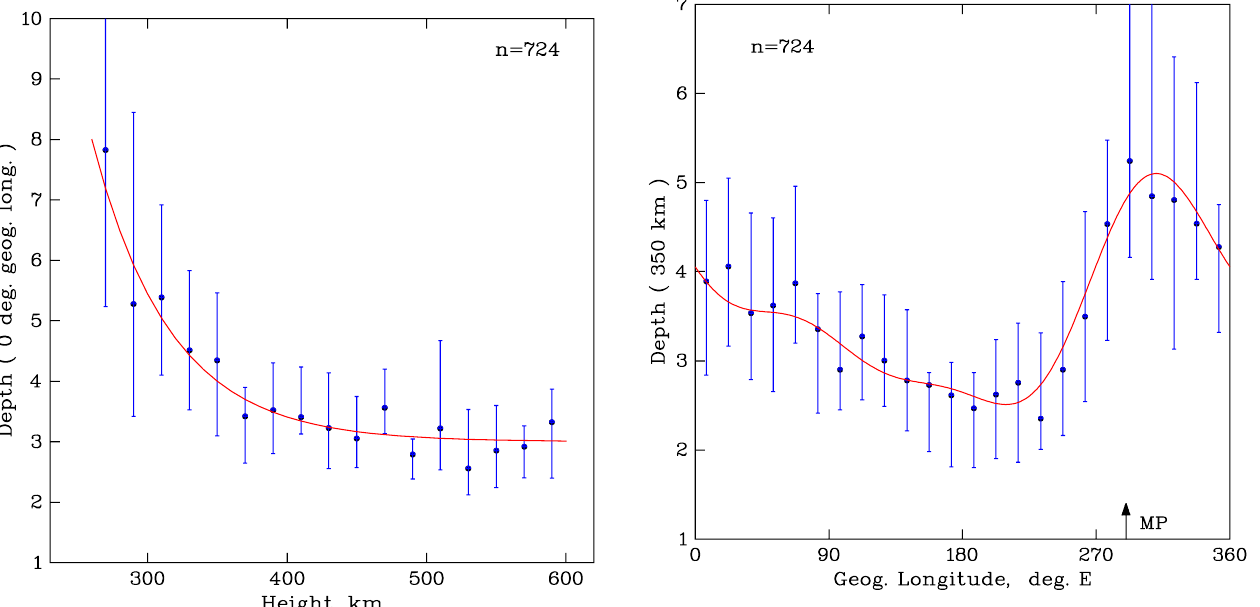
Fig. 6. Height variation of the magnitude of the density drop in the equatorward trough wall. This magnitude is denoted here as depth. It is defined as the ratio of the density values observed at the equatorward ( Neb ) and poleward ( Nem ) boundaries of the trough wall. For each 20km-wide height interval, the median and the up- per and lower quartiles of this parameter were determined; see the blue dots and bars. Subsequently, the height variation of the median values was approximated by an exponential function; see Eq. (5). Note that the results presented in this figure apply to a geographic longitude of 0 degree.